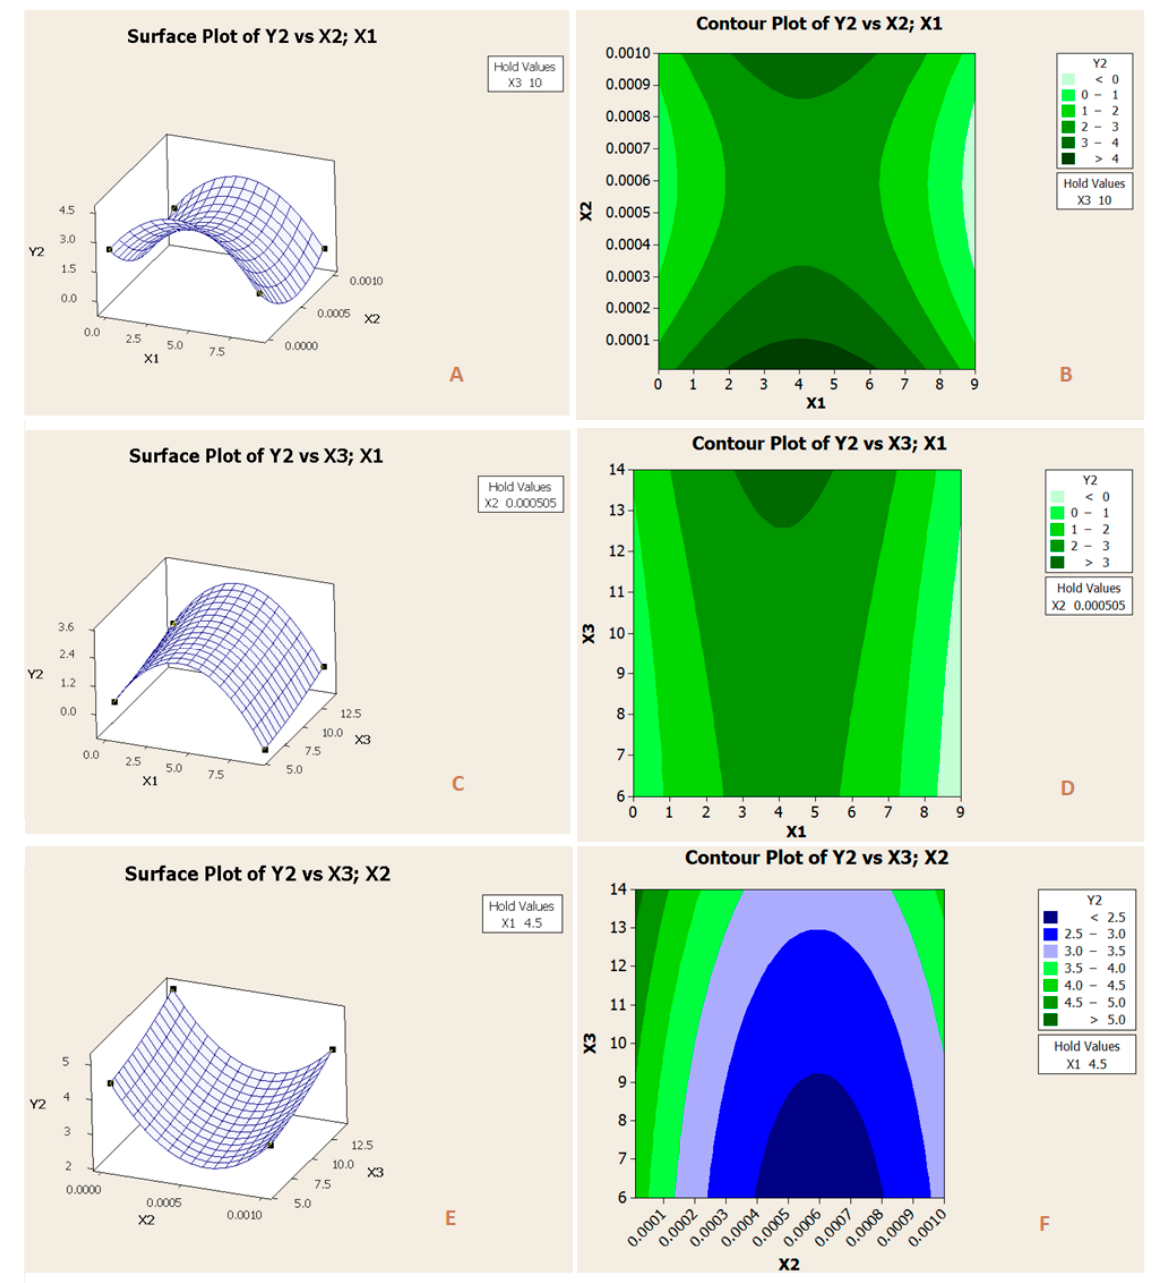
Figure 11. Surface plot ( A , C , E ), and contour plot ( B , D , F ) of the parameters impacts (PES concentrations (x 1 ), pH (x 3 )) on permeate flux.